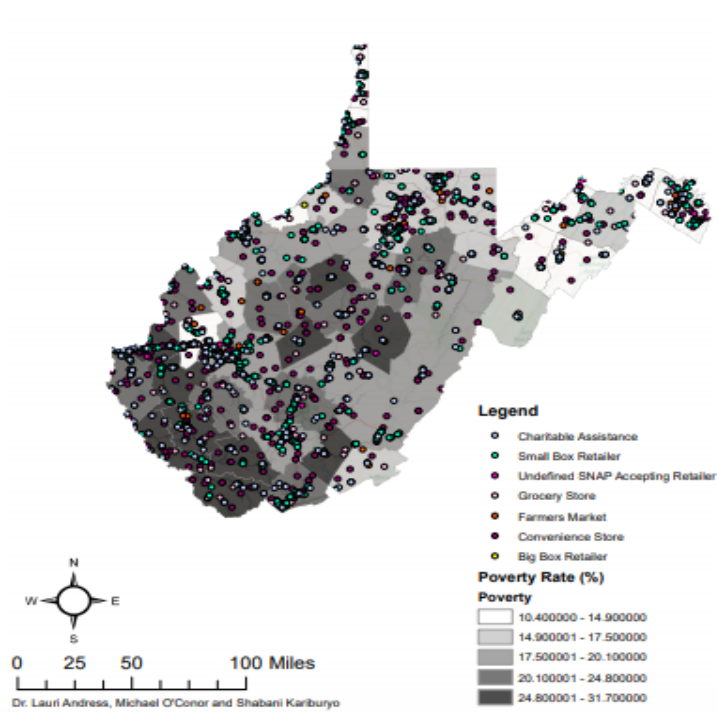
Figure A1. Food retail distribution and poverty rates.